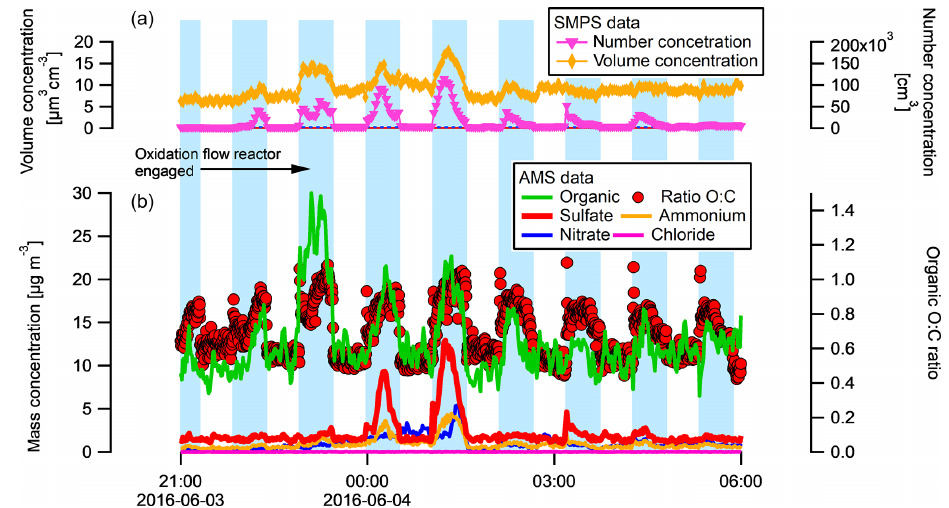
Figure 5. Atmospheric processing simulated though an oxidation flow reactor (OFR). OFR measurements are shown in light blue back- ground. (a) SMPS number and estimated volume concentration. (b) SP-AMS chemical species concentrations and organic O : C